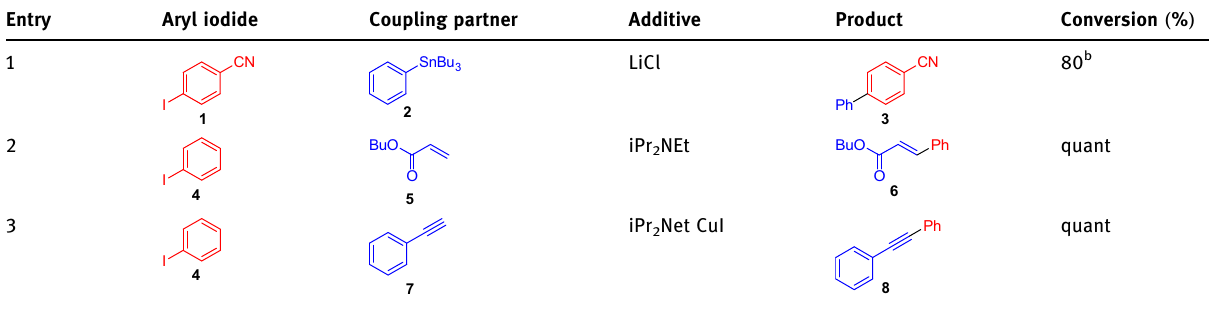
Entry Aryl iodide Coupling partner Additive Product Conversion ( %